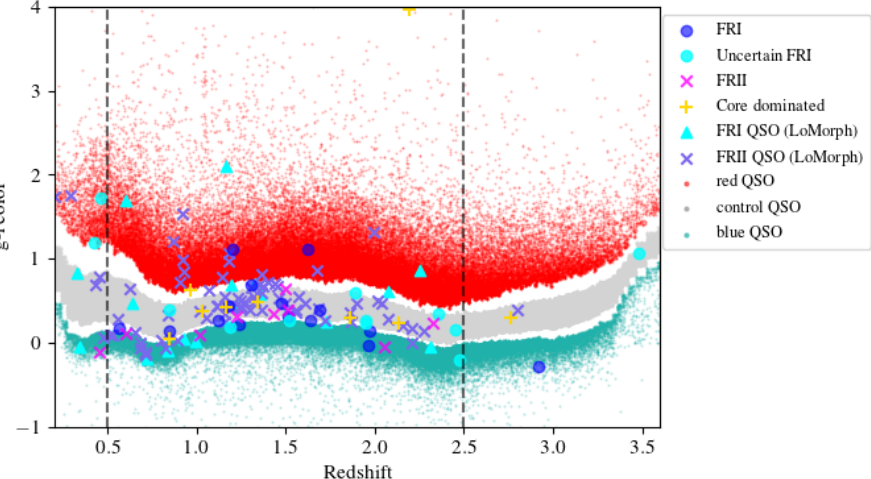
figure that: (i) The majority of FRI quasars do not have red optical colours and (ii) there is no clear difference between the optical colours of FRI and FRII quasars.